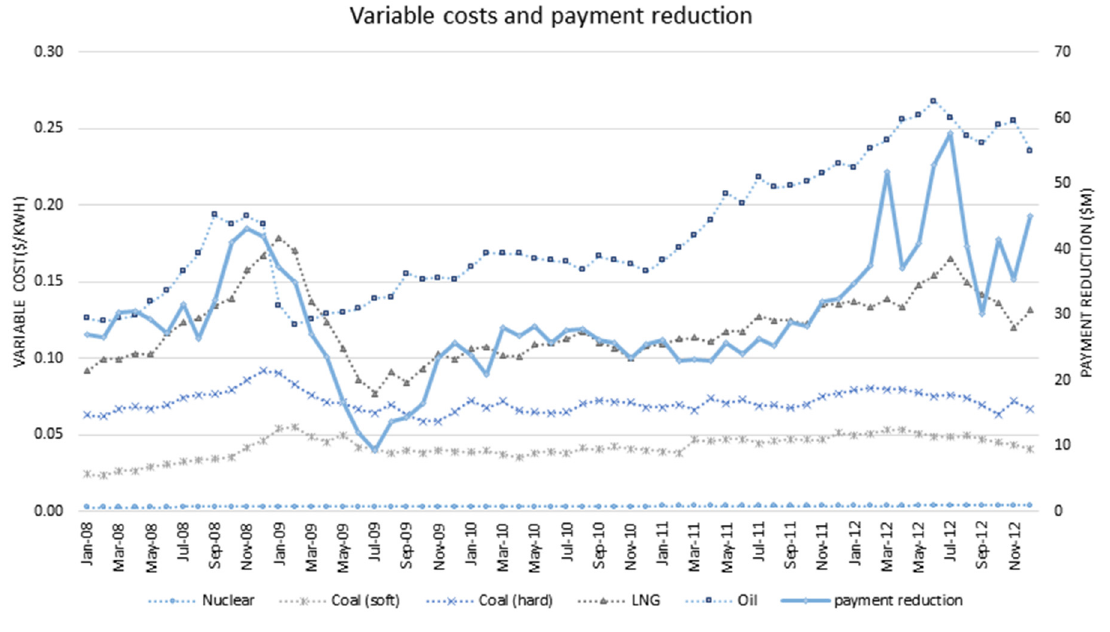
Figure 8. Estimated payment reduction and variable